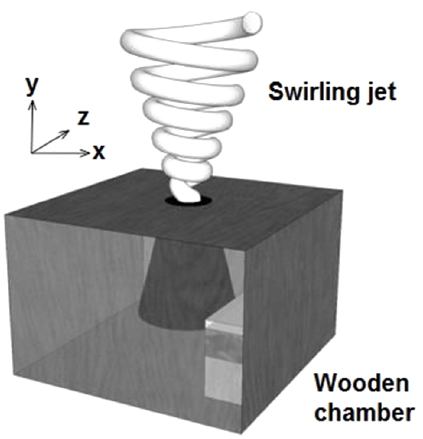
Figure 2. Schematic of the experimental setup. The swirl nozzle is located within the wooden chamber.